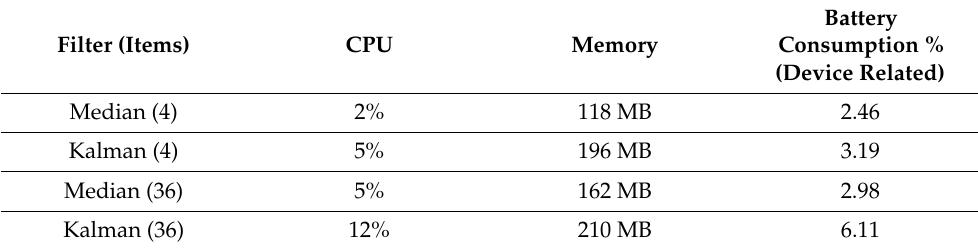
Table 2. Summary of Median and Kalman filter footprint.